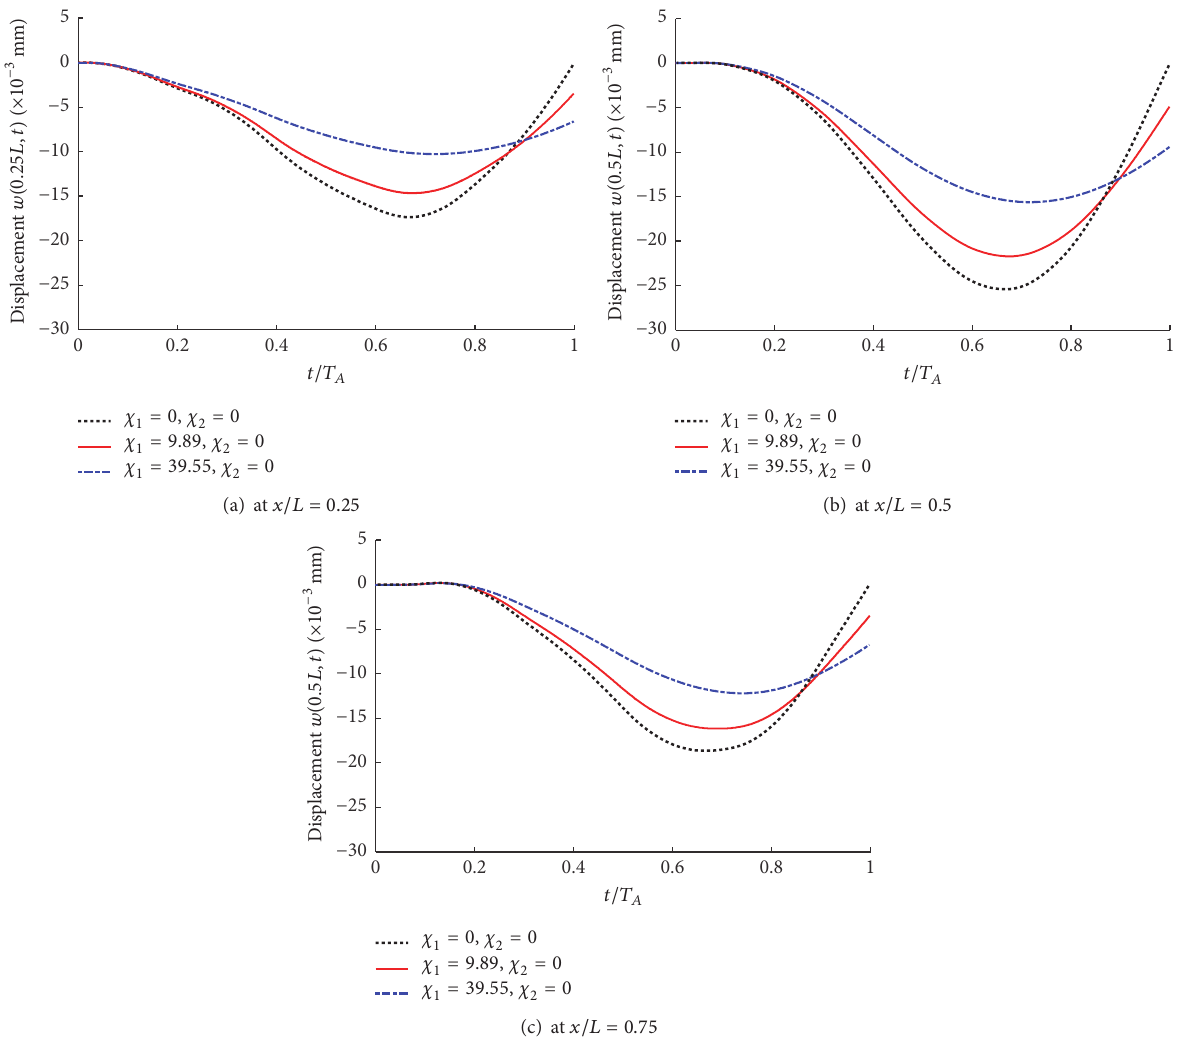
Figure 13: Effects of viscous damping on the transverse displacements at three locations of a simply supported Timoshenko beam subjected to a point transverse force moving at a constant speed of V 𝑓 = 0.5 V cr when 𝜒 1 = 0, 9.89 and 39.55 with 𝜒 2 = 0 : (a) at 𝑥/𝐿 = 0.25 ; (b) at 𝑥/𝐿 = 0.5 ; (c) at 𝑥/𝐿 = 0.75